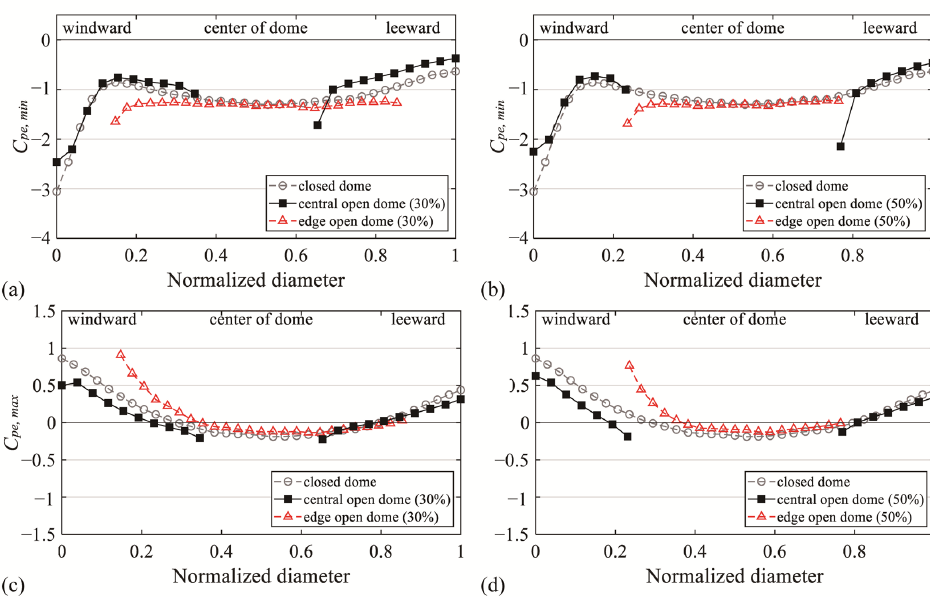
Figure 16. Comparison with edge open domes: ( a ) C pe,min of H/D = 0.5 (open ratio = 30%), ( b ) C pe,min of H/D = 0.5 (open ratio = 50%), ( c ) C pe,max of H/D = 0.1 (open ratio = 30%), and ( d ) C pe,max of H/D = 0.1 (open ratio = 50%).